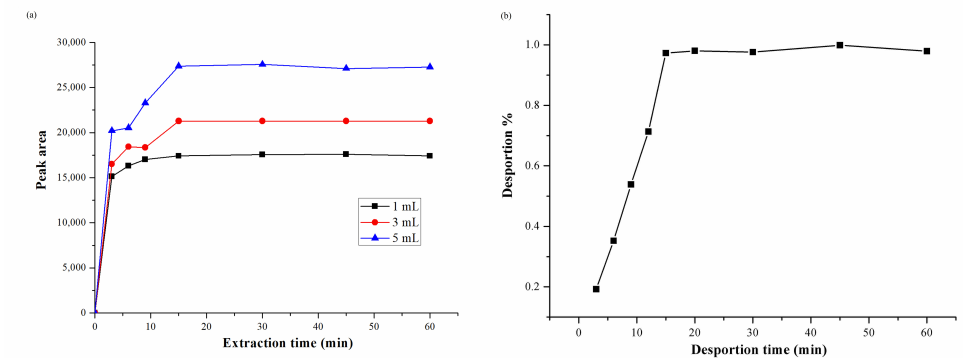
Figure 7. ( a ) Dynamic adsorption isotherms of MMIPs of 4-MEI in three sample volumes (i.e., 1, 3, and 5 mL); ( b ) effect of desorption time.